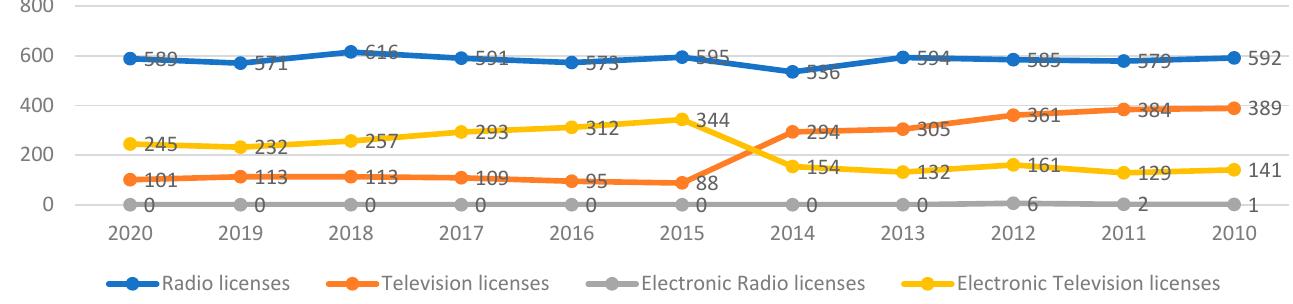
Figure 3. Evolution of media licensing in 2010–2020.